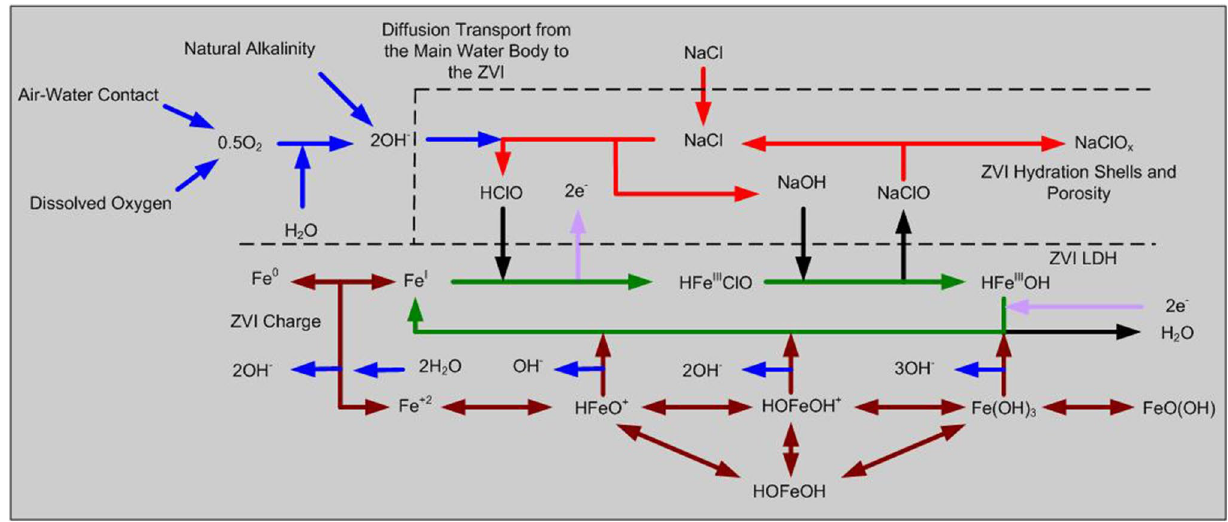
Fig. 7 Catalyst A: simplified schematic diagram illustrating the interaction of OH with the ZVI. LDH layered double hydroxide. e − interactions with the reduction of FeO x and Fe(OH) x to Fe n + are not shown